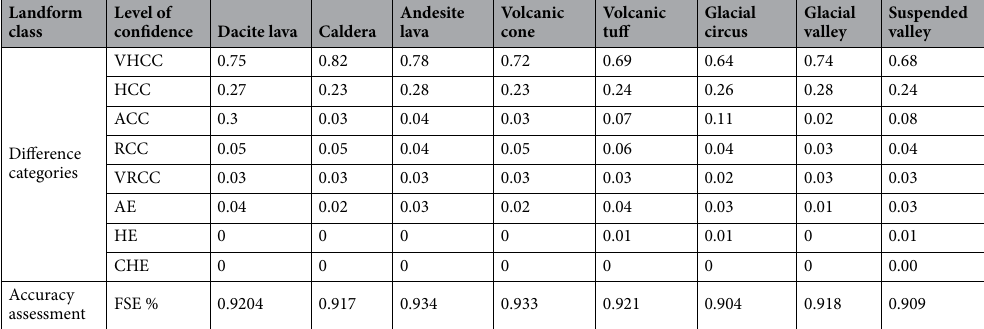
Table 8. Sample observation proportions for Difference categories and validation of object-based features for volcanic and glacial landforms.